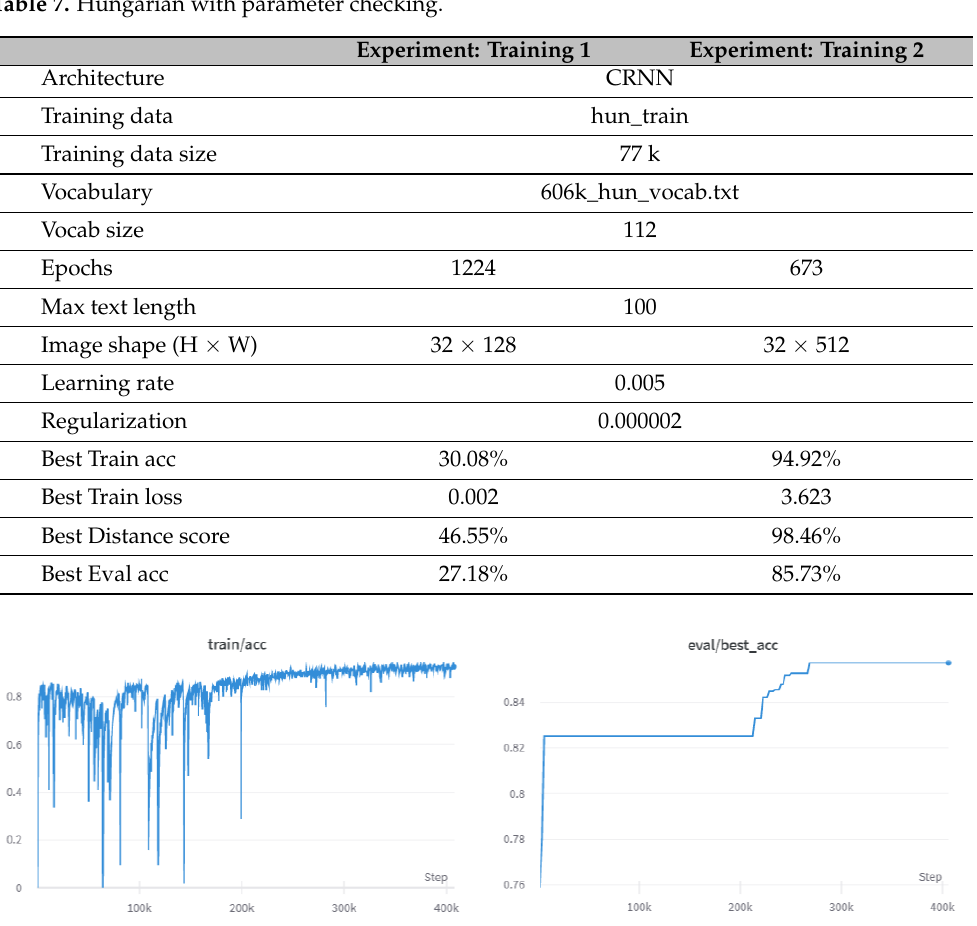
Figure 7. Best training and evaluation accuracy of Training 2.